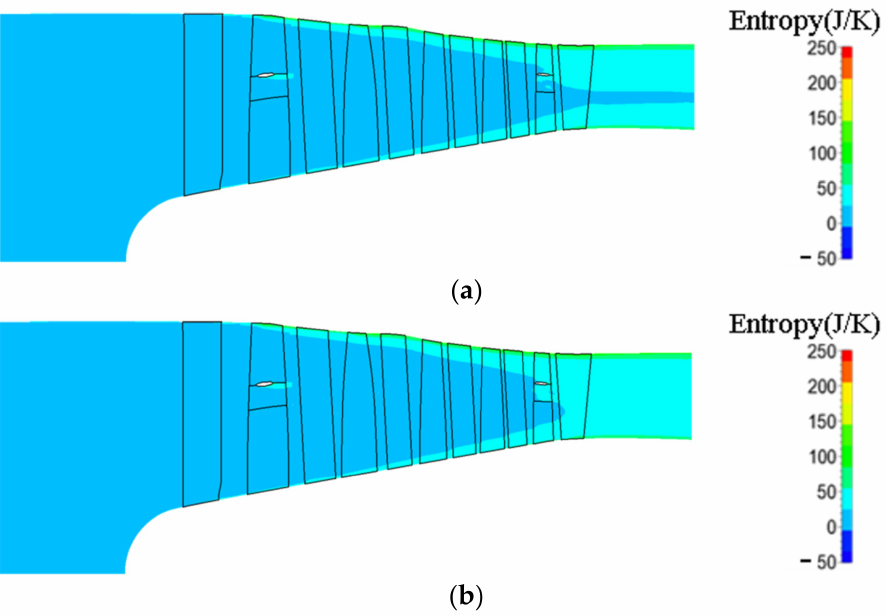
Figure 8. Comparison of pitch-averaged entropy distribution under the peak total efficiency with different roughness conditions. ( a ) ABPT, ( b )